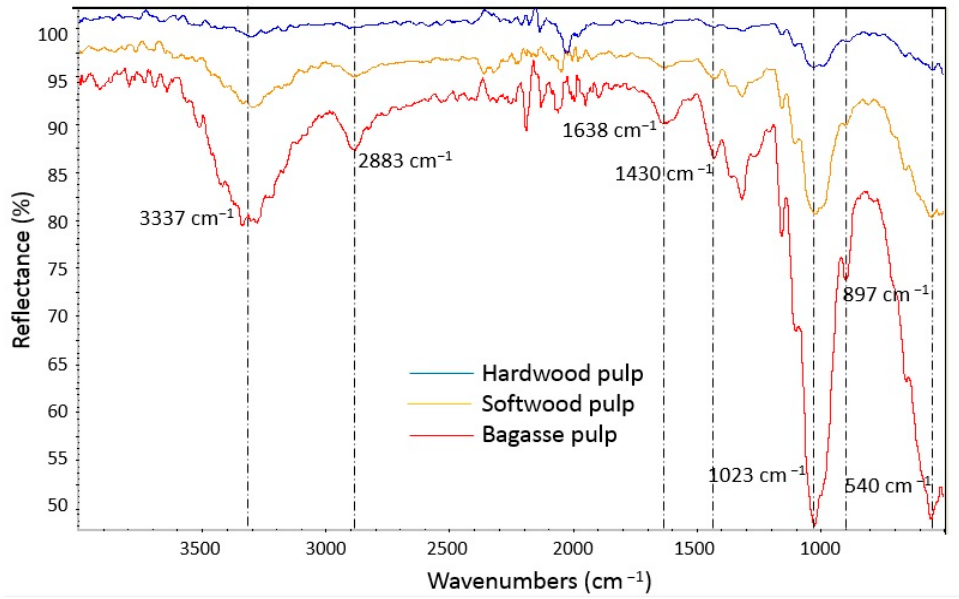
Figure 3. FTIR spectra of softwood pulp, hardwood pulp and bagasse pulp.